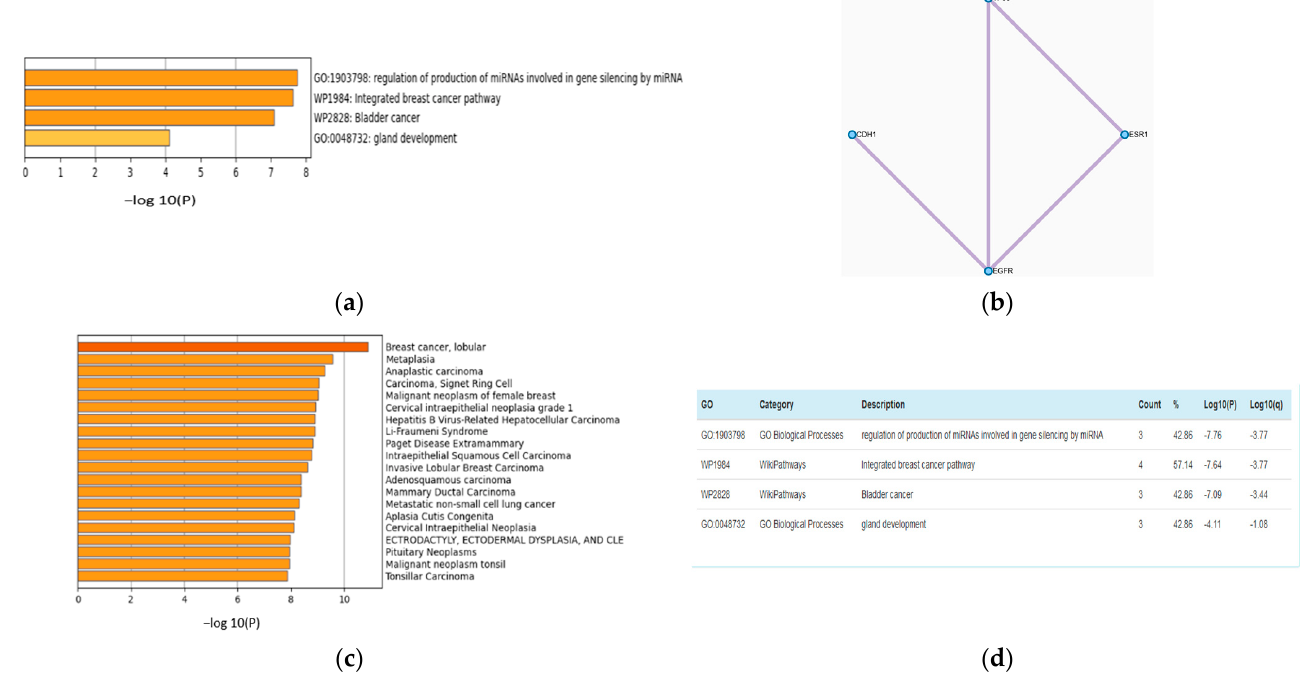
Figure 3. Analysis of genes from mutation omics data using Metascape. ( a ) GO Analysis. ( b ) Protein– protein interactions of the shortlisted genes. ( c ) DisGeNET analysis reflecting the top ranked gene contributions to BC. ( d ) Wiki and Go pathway